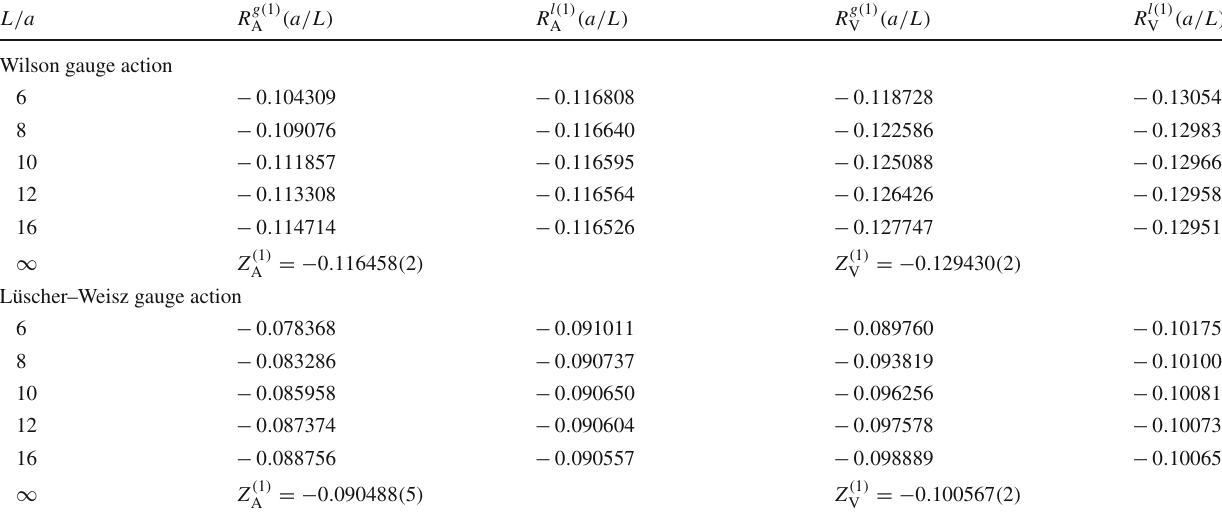
Table 1 Finite L / a estimators for the current normalization constants at 1-loop order, and our estimates for their asymptotic values; the latter agree with previous results in the literature [33–35]. All results are given for SU ( 3